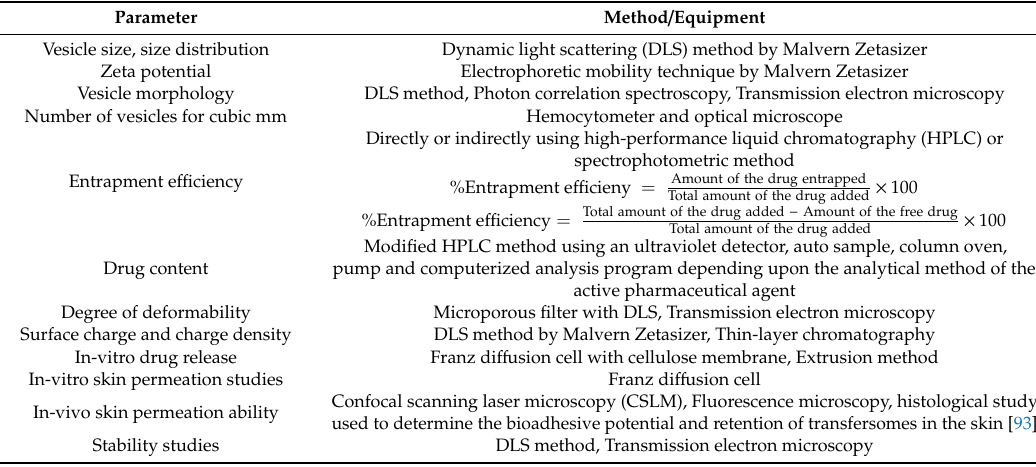
Table 1. Parameters and the testing methods of